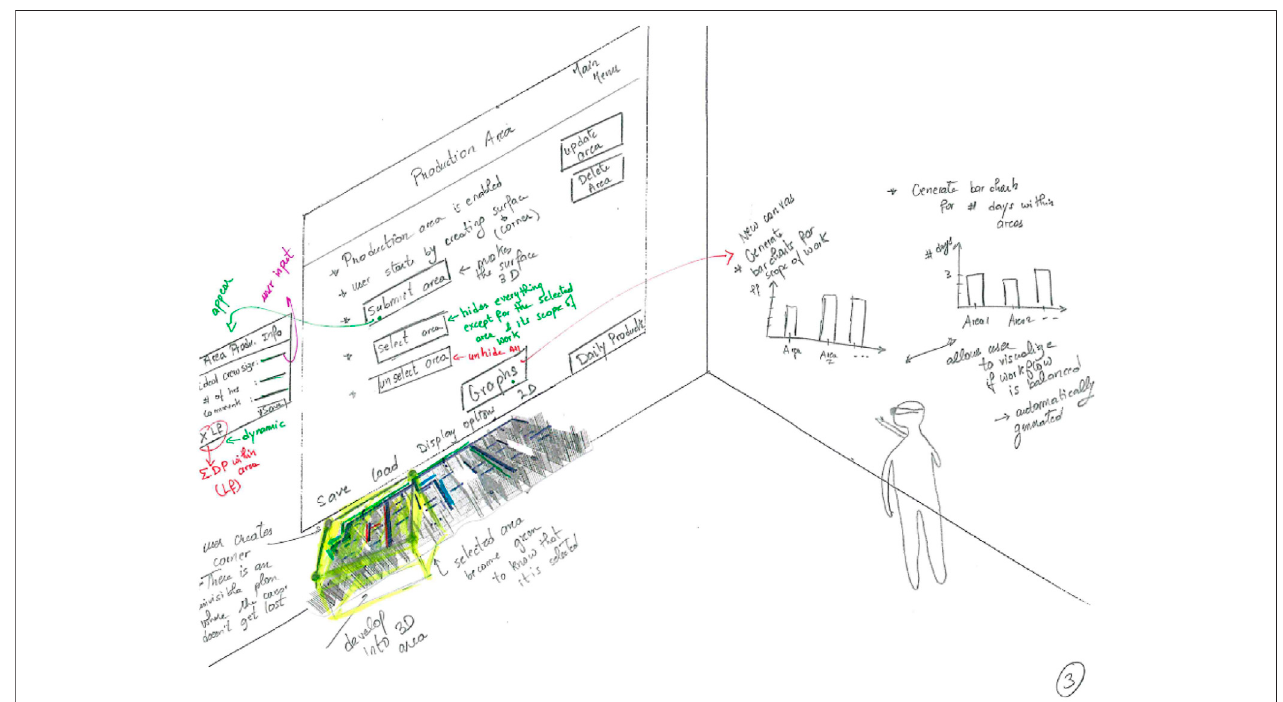
FIGURE 2 | Example of the Paper Prototype created for the AR-enabled PSP Prototype.